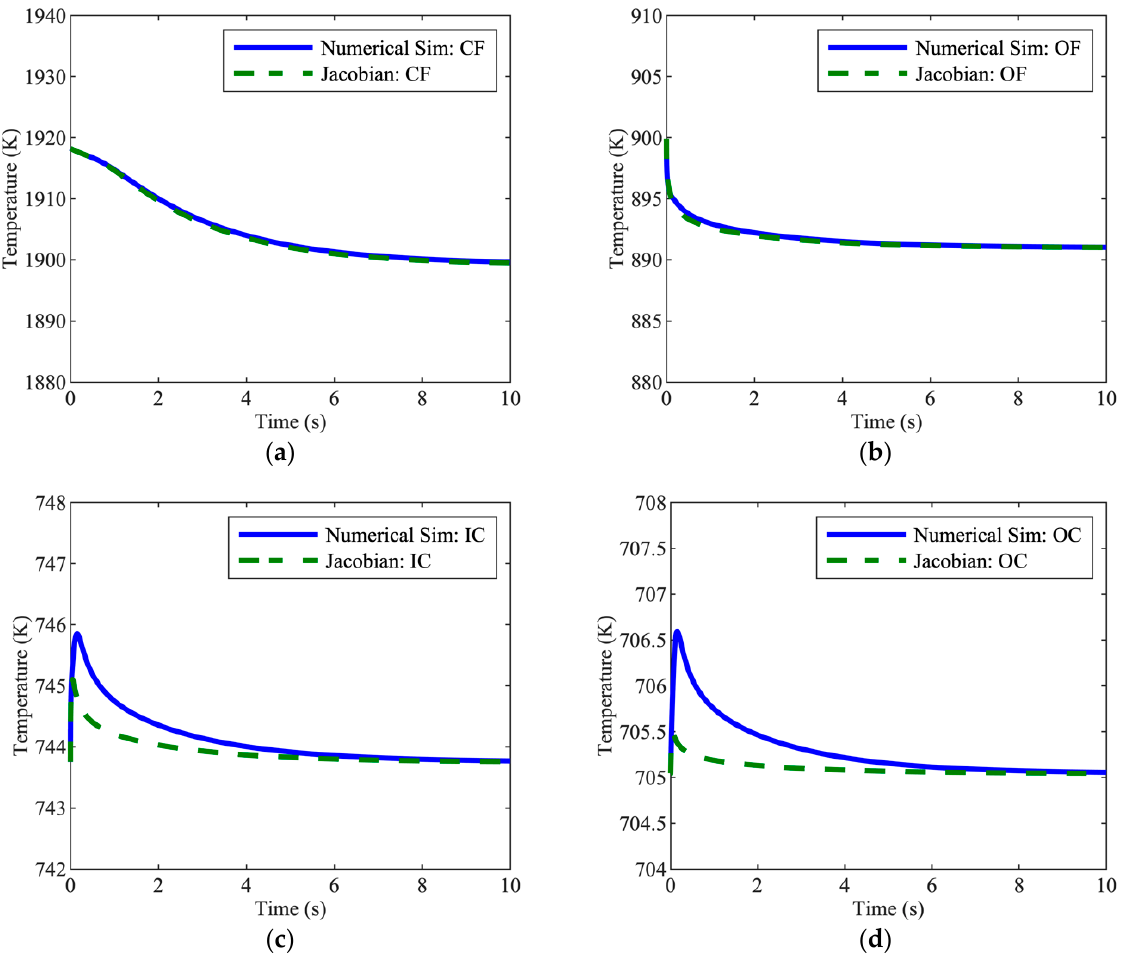
Figure 6. Temperature evolutions at various radial positions (CF = centerline fuel, OF = outer fuel, IC = inner cladding, and OC = outer cladding) during the 1% all-fuel temperature perturbation. (a) Temperature evolution at the fuel centerline node. (b) Temperature evolution at the outer fuel node. (c) Temperature evolution at the inner cladding node. (d) Temperature evolution at the outer cladding node.